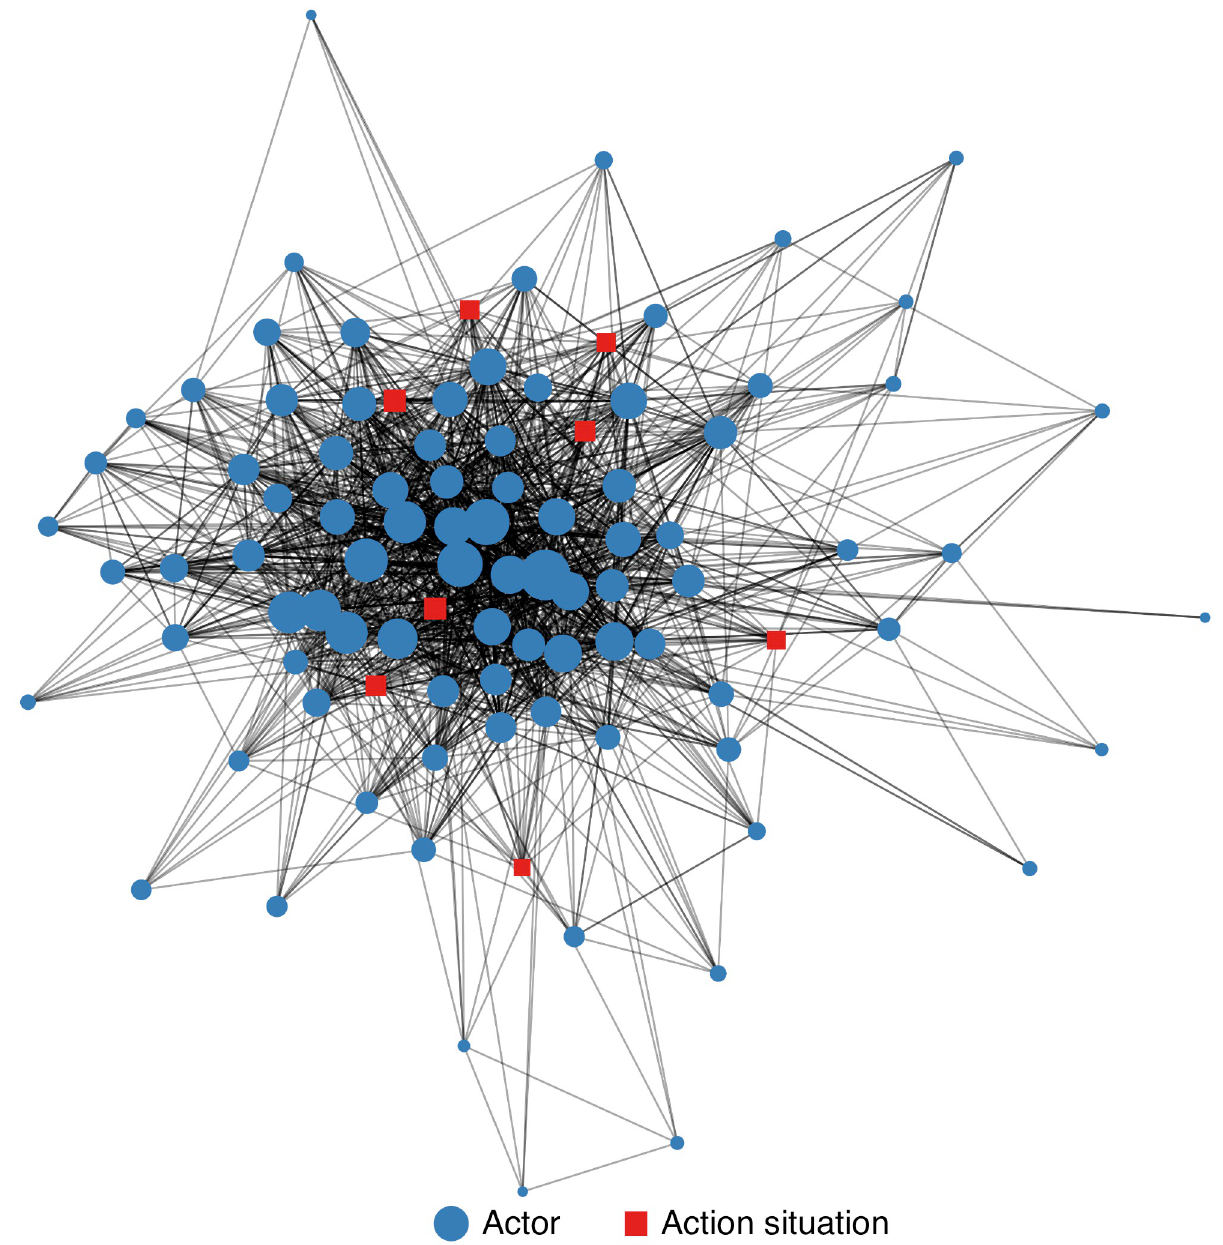
Fig 1. Network of actors (blue circles) and action situations (red squares) engaged in water quality governance in the LCB. Nodes are scaled relative to their degree centrality.